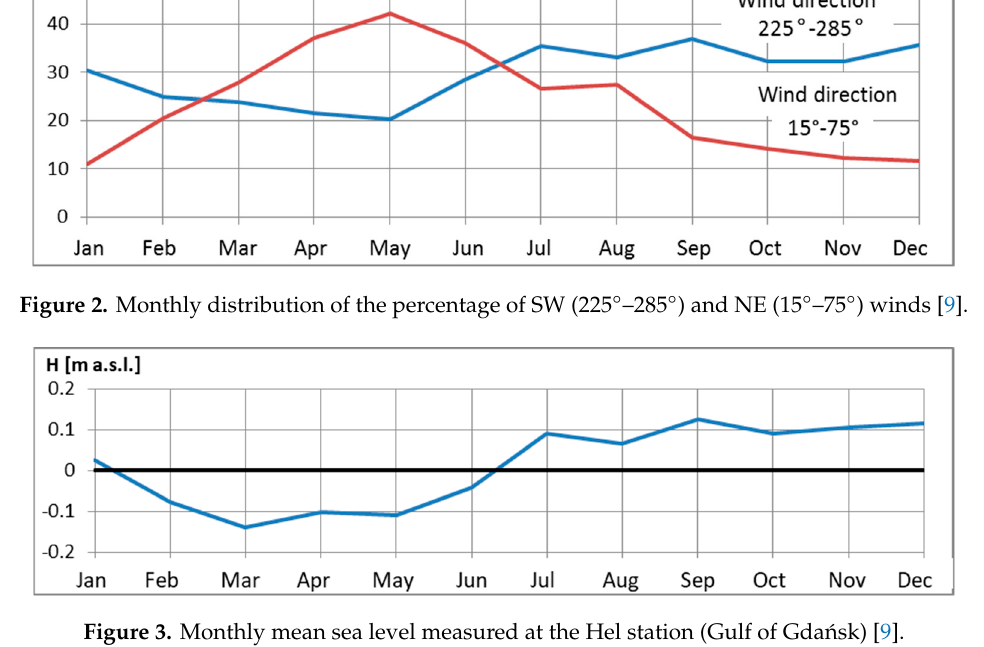
Figure 3. Monthly mean sea level measured at the Hel station (Gulf of Gda ń sk) [9].